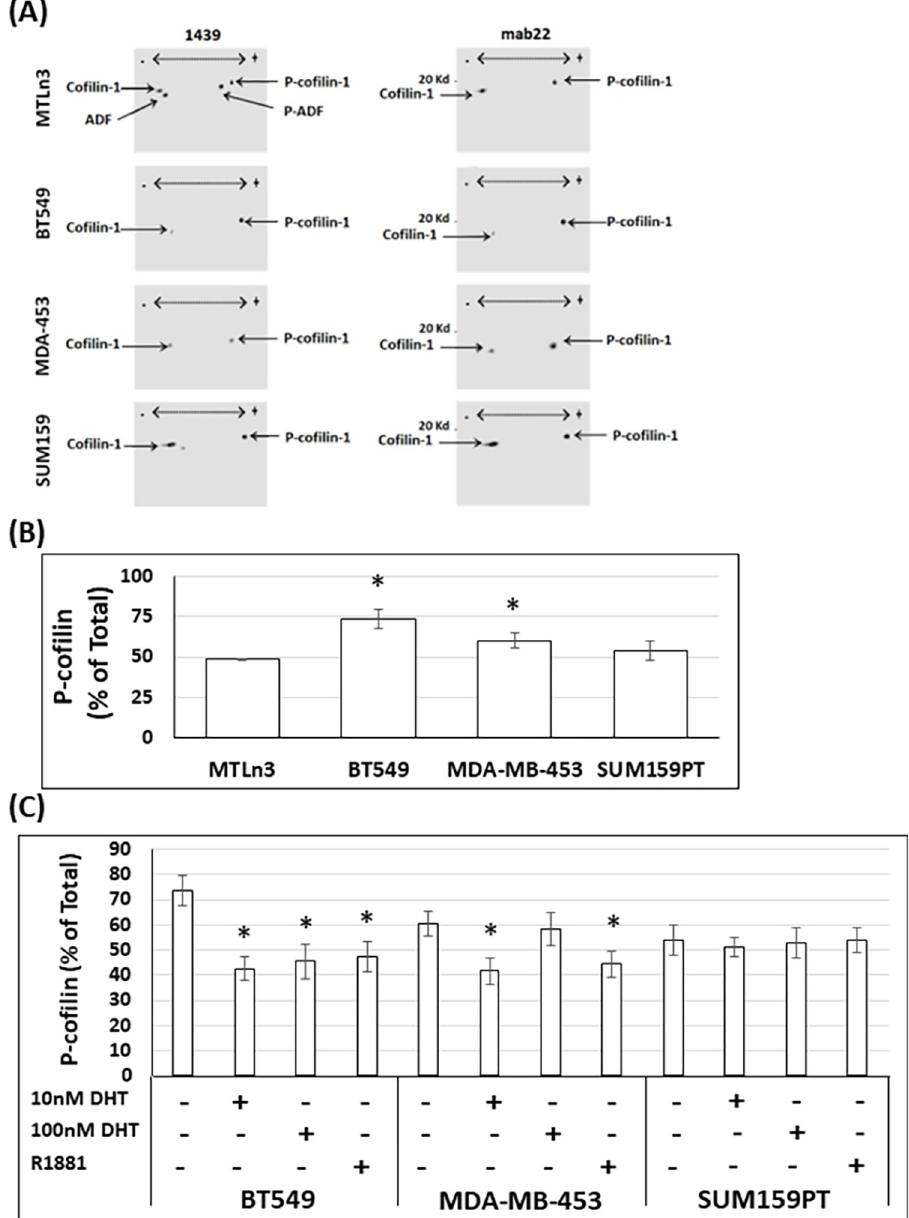
Fig 2. TNBC cell lines express different protein levels of cofilin phosphorylated form and androgen treatment changes these protein levels. (A) Representative 2D western blots of extracted TNBC and rat MTLn3 cell proteins immunolabeled with rabbit polyclonal antibody (1439) that recognizes ADF, phospho-ADF, cofilin, and phospho- cofilin with equal sensitivity or a monoclonal antibody to total cofilin (mAb22). The experiment was repeated three times and the corresponding quantification is shown in (B). (B) Quantification of cofilin level and its phosphorylated form in vehicle-treated control TNBC cells obtained from densitometers of immunoblots. � p < 0.05 versus MTLn3 cells. (C) Quantification of levels of cofilin and its phosphorylated form in androgen-treated cells as compared to vehicle-treated control TNBC cells obtained from densitometers of 2D immunoblots (S1 Fig). The experiment was repeated three times. � p < 0.05 versus